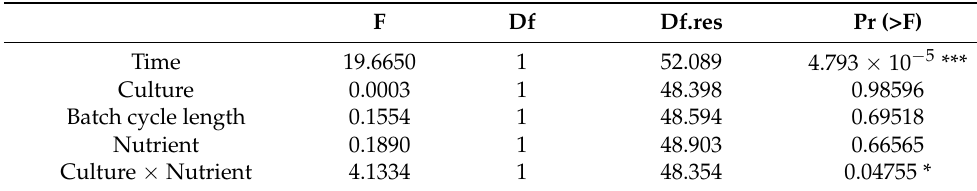
Shannon’s diversity index of C. affinis genotypes significantly decreased with time as a result of increased dominance of the four major contributing genotypes (Figure 4; “Time”, Table 5). Diversity was interactively affected by culture and nutrient regime (“Culture × Nutrient”, Table 5). This interaction was reflected in a 12% diversity decline from 10N:1P to 30N:1P in the mix-cultures compared to a 29% increase with the nutrient regime in the mono-cultures. The composition of C. affinis genotypes was largely structured by nutrients. The 20N:1P and 30N:1P nutrient regimes were dominated by genotype B82 (“Nutrient”, Table 6), while the 10N:1P regime was mainly composed of genotype B57 (“Nutrient”, Table 7). Variable batch cycle length led to a higher proportion of genotype B57 (“Batch cycle length”, Table 7), while fixed batch cycle length favored genotype B67 (“Batch cycle length”, Table 8). Additionally, genotype B67 , which at midterm in some of the samples was below detection limit, increased with time in all treatments (“Time”, Table 8) and genotype B82 was more abundant in mix-cultures compared to mono-cultures (“Culture”, Table 6). Table 5. Analysis of deviance table of Type II Wald F tests with Kenward-Roger df for linear mixed- effects model with Shannon’s diversity index of C. affinis as response variable. Stars show significance level of the test; *** p < 0.001 and * p < 0.05. F Df Df.res